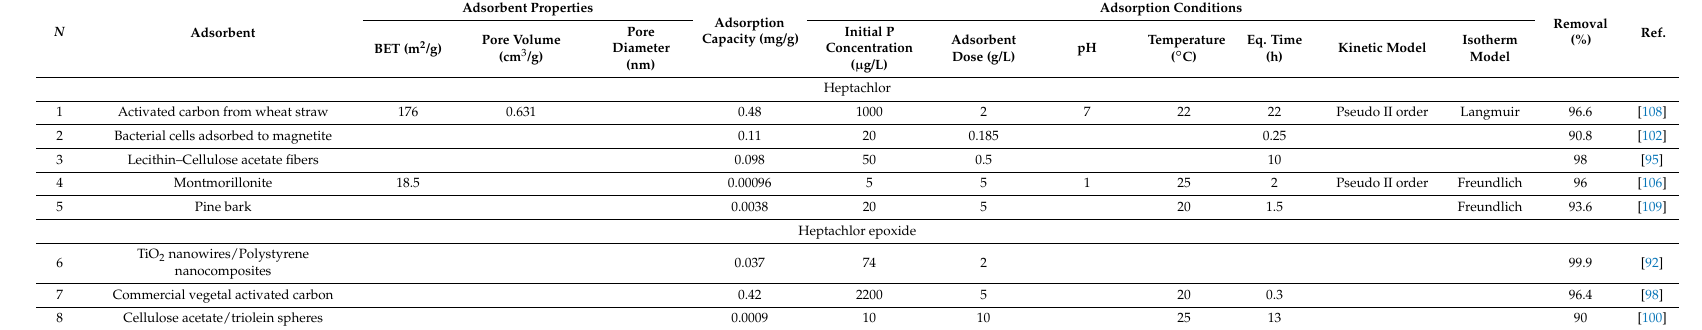
Table 14. Nanofibrous adsorbent properties and adsorption conditions for the removal of Heptachlor and Heptachlor